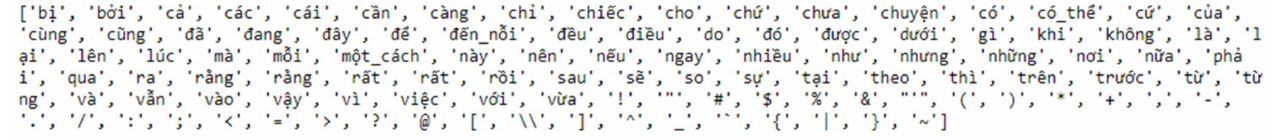
Figure 4. Building stop word and punctuation.